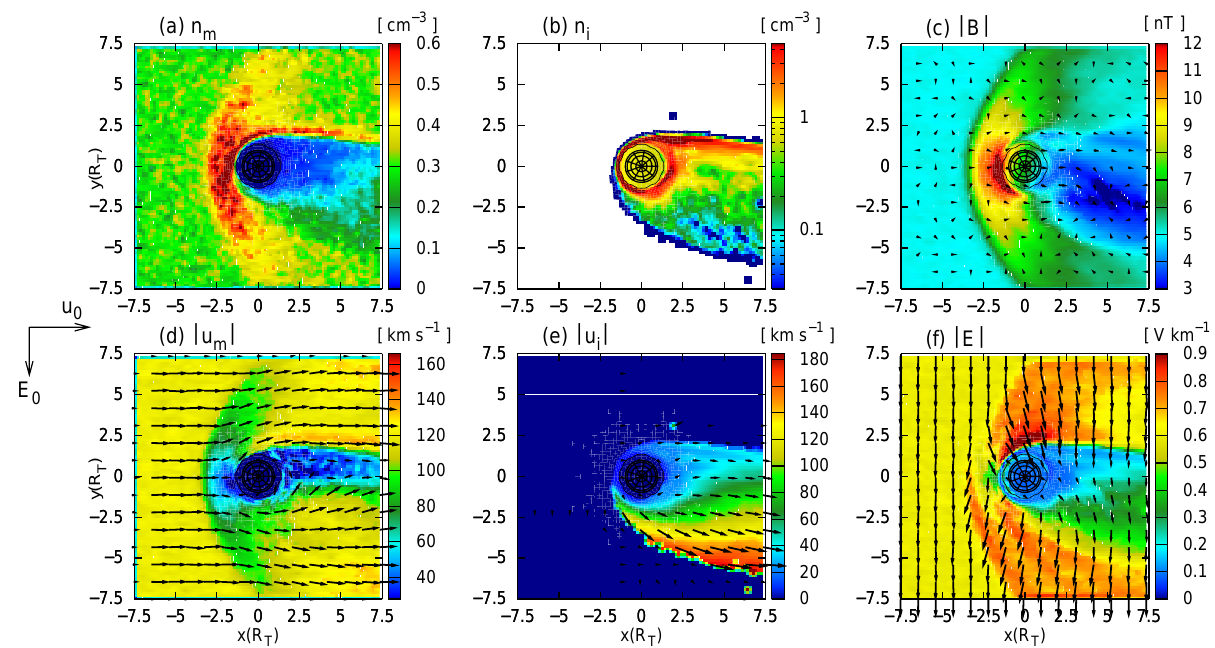
Fig. 8. Interaction of Titan’s ionosphere with a supersonic plasma flow – cut through the (x,y) plane of the simulation box which coincides with Titan’s equatorial plane. The undisturbed plasma flow is directed in ( + x) direction, whereas the background convective electric field E 0 is antiparallel to the z axis. The figure shows (a) the mean (N + /H + ) plasma density, (b) the ionospheric plasma density, (c) the magnetic field, (d) the mean (N + /H + ) velocity, (e) the mean ionospheric ion velocity and (f) the electric field in the cutting plane. The simulation results exhibit an asymmetry between both hemispheres. The ionospheric tail as well as the region of reduced electric field strength cover a large area in the E + hemisphere, whereas they are confined by a sharp boundary layer in the E − hemisphere. In the E + hemisphere, an extended pick-up region is formed where ionospheric ions are incorporated into the ambient plasma flow. Since their velocity is comparable to the ambient plasma velocity, the pick-up ions make a significant contribution to the convective electric field. For this reason, the decrease of electric field strength in the tail region is less strong than in the E − hemisphere. In the E + hemisphere, the convective electric field points inward the ionospheric tail preventing these ions from crossing the ICB from inward to outward and mixing with the ambient plasma flow. In this half space, the sharp decrease of ionospheric ion density at the ICB gives rise to a strong electron pressure gradient pointing inward the tail region. Hence, the ambient plasma is forbidden to cross the ICB from outward to inward by the electric field arising from the negative electron pressure gradient. As can be seen from (d), in the E − hemisphere the plasma flow is almost tangential to the boundary layer. In contrast to the situation in the E − hemisphere, the convective electric field points away from the ionospheric tail in the E + hemisphere. Hence, the focussing effect being responsible for the sharp separation of both plasma populations in the E − hemisphere does not occur and the boundary layer cannot be formed. The electric force acting on the ionospheric ions makes them mix with the ambient plasma flow where they are picked up and begin to perform a cycloidal motion in ( + x) direction. This gives rise to the extended ionospheric tail region in the E + hemisphere. Both the convective electric field and the field resulting from the electron pressure gradient are essential for the occurence of asymmetries in the structure of the